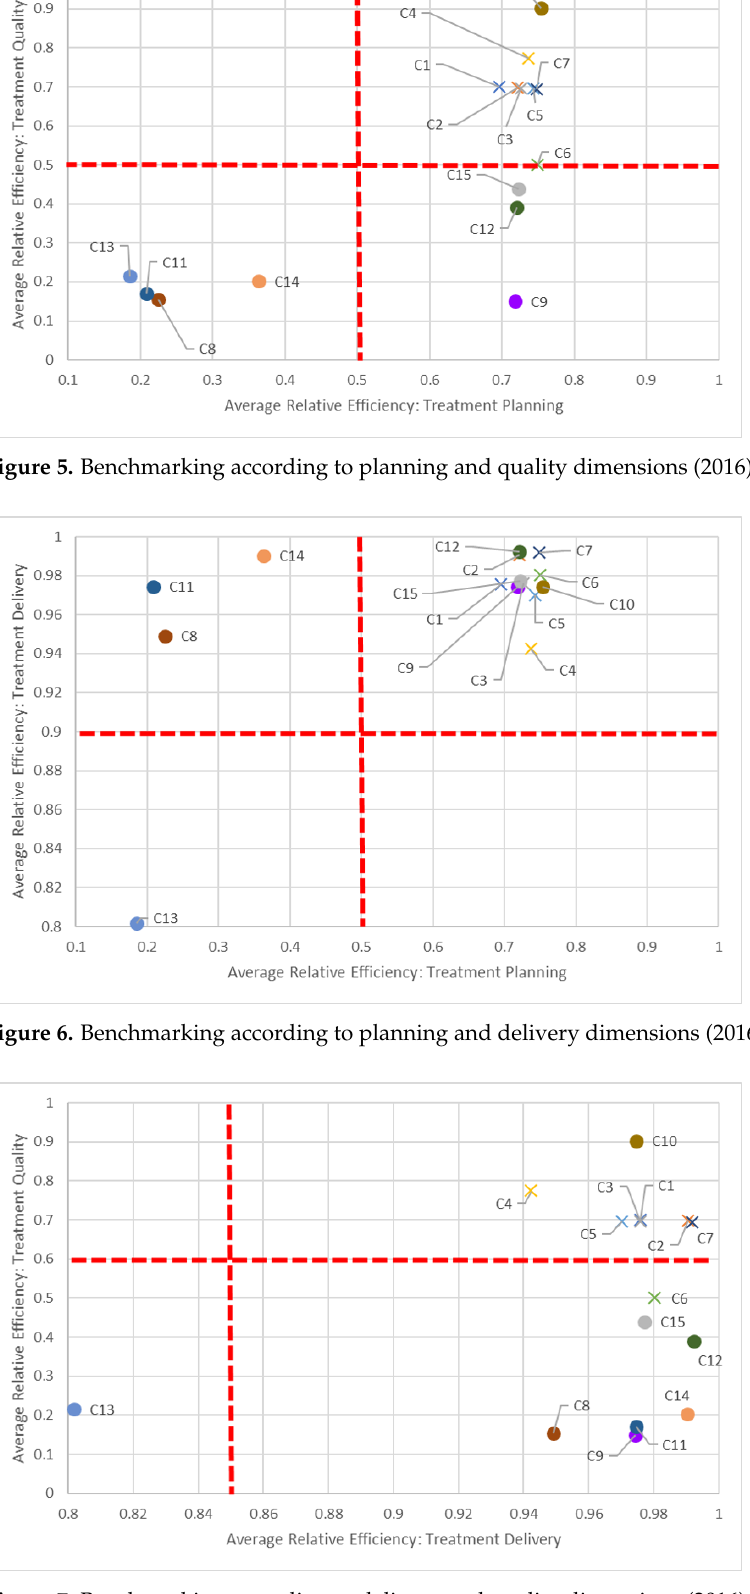
Figure 7. Benchmarking according to delivery and quality dimensions